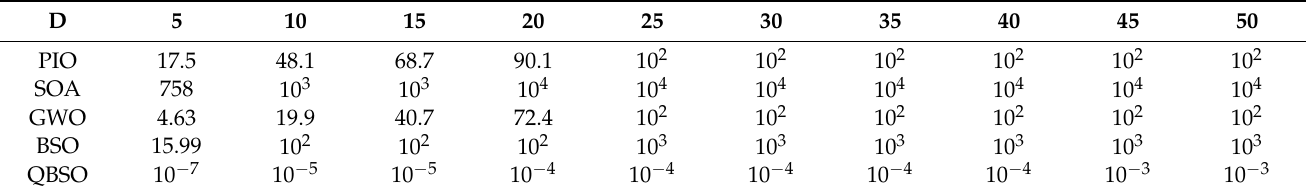
Table 7. Comparison results of the impact of dimensions on algorithm